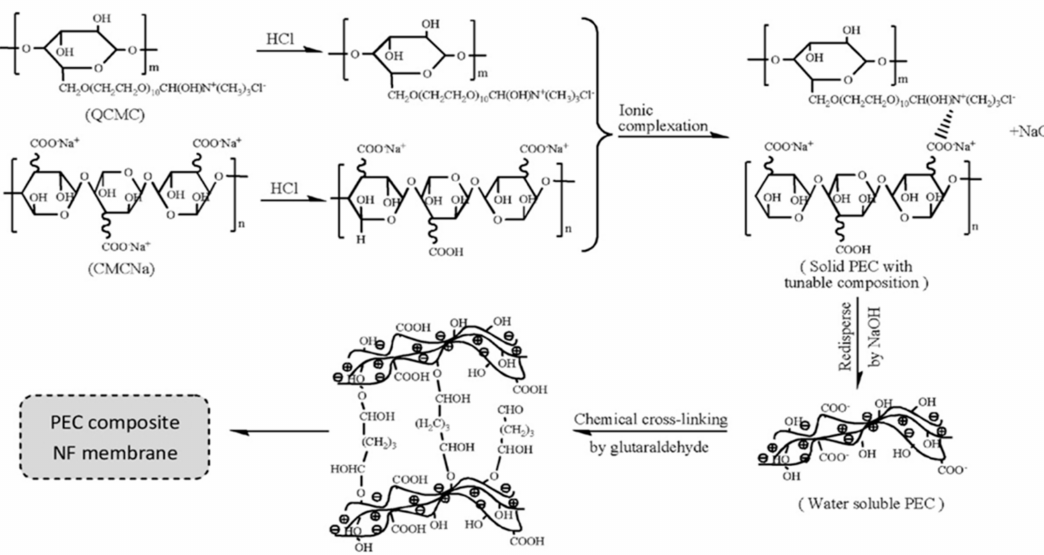
Figure 13. Schematic diagram for preparing polyelectrolyte complexes (PECs) and their composite nanofiltration (NF) membranes. Reproduced with permission from Reference